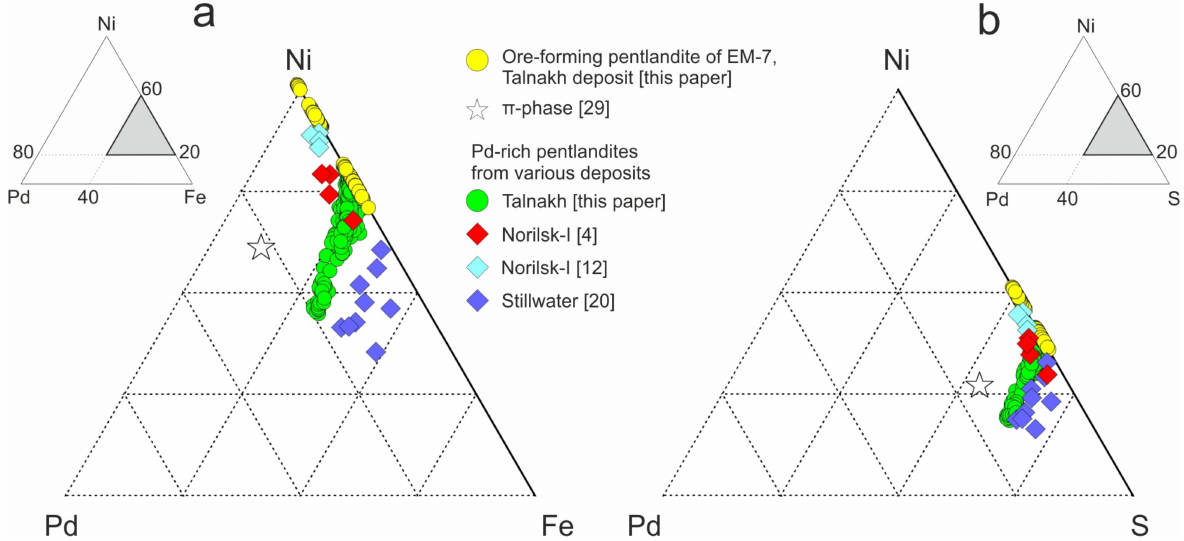
Figure 10. Ternary plots, showing the differences in chemical composition in wt.% between π -phase, ore-forming and Pd-rich pentlandites from various deposits: ( a ) Diagram Pd-Ni-Fe; ( b ) Diagram